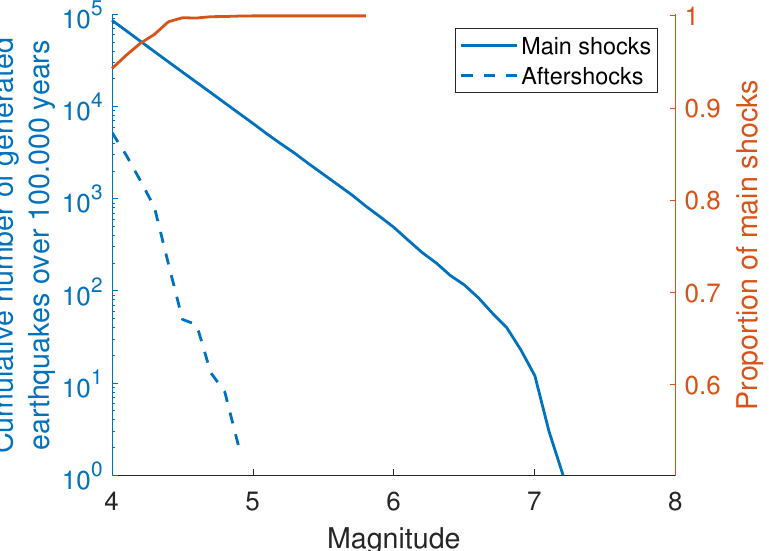
Figure 3. Example of number of aftershocks generated over 100,000 years. This number is obtained from examples of number and proportion of main shocks (Equation